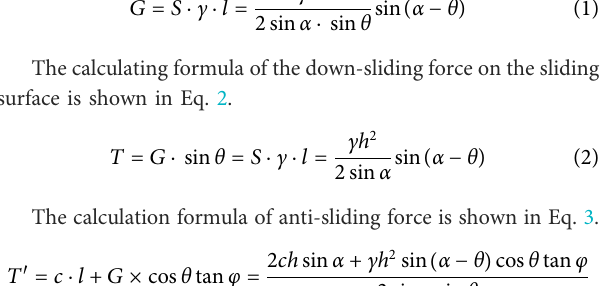
FIGURE 13 Geometric physical diagram of